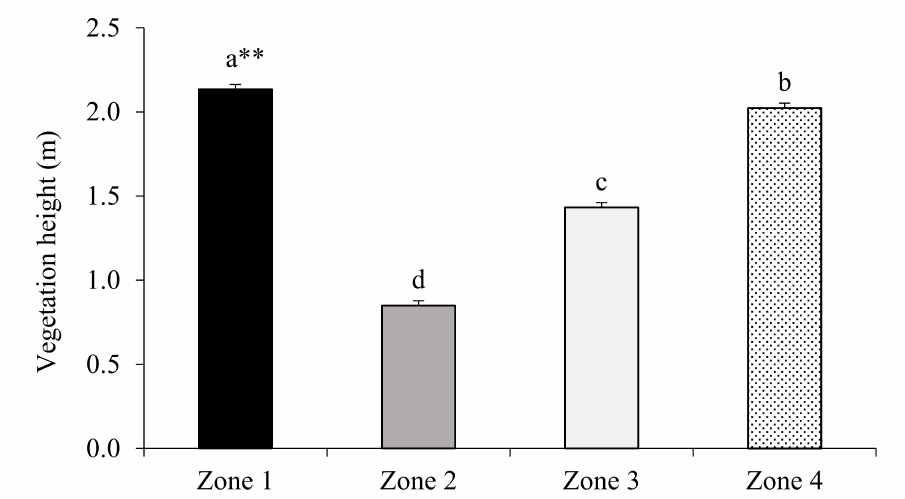
Figure 4. Understory vegetation heights (LS means ± SE) in different zones in woodlands, June– August 2018, Atkins Agroforestry Research and Demonstration Site, Tuskegee University, Tuskegee, AL, USA ( a,b,c,d LS means with different superscripts between different study zones differ, ** p < 0.01). Zones 1 to 4 are defined in Figure 1.